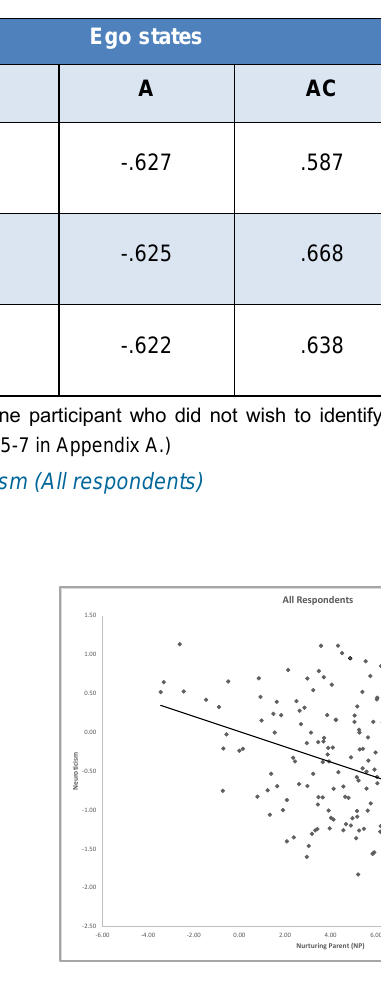
Figure 1. Weak negative r between Nurturing Parent (NP) and Neuroticism.